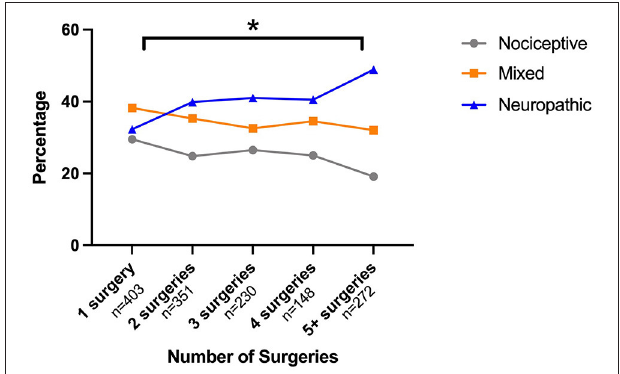
FIGURE 1 | Relationship between painDETECT scores and number of abdominal surgeries. Surgeries were grouped so that each group had approximately the same number of participants. Surgery group 1 had one surgery to the abdomen, group 2 had two surgeries, group 3 had three to four surgeries and group 4 had five or more surgeries. Post-hoc tests showed significant differences between group 1 and group 4 in painDETECT scores ( p < 0.001).